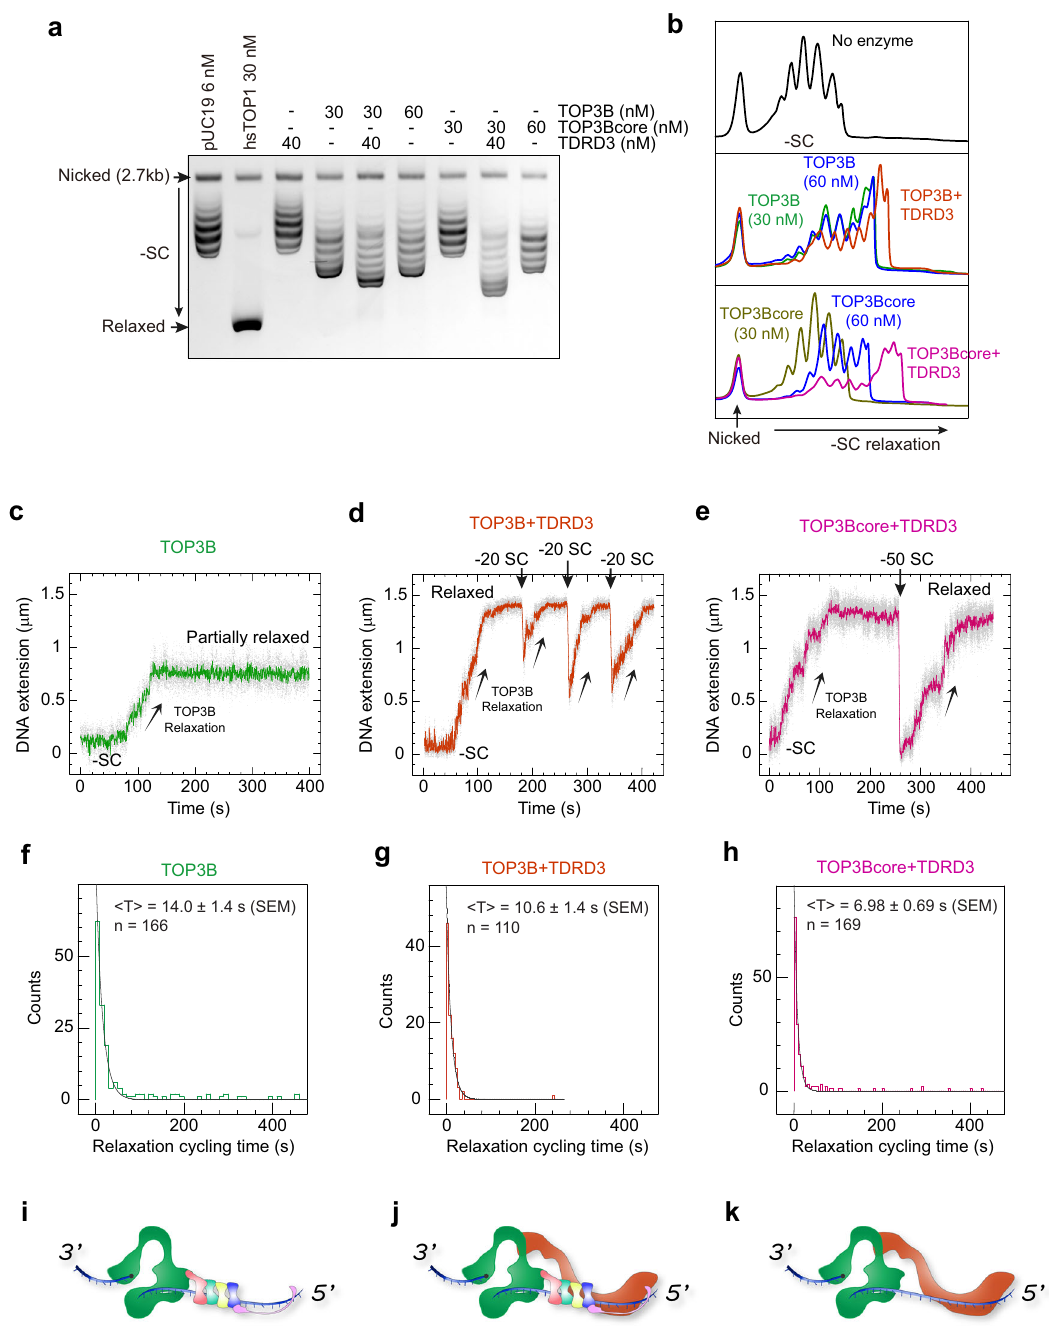
Fig. 6 | TDRD3 enhances both the processivity and catalytic rate of TOP3B. a Gel-based plasmid relaxation assay with TOP3B and TOP3Bcore in the presence and absence of TDRD3 (repeated twice independently with similar results). Ethi- diumbromide(0.15 μ g/ml)wasaddedtoboththeagarosegelandrunningbufferto convert the negatively supercoiled (-SC) DNA substrate and products into slightly overwound topoisomers. Fully relaxed plasmids by hsTOP1 were included (second lane) as a positive control. Numbers indicate the concentrations of DNA substrate and enzymes used. DNA relaxation assays were performed at 37°C for 1hr. b Quanti fi cationofDNAtopoisomerdistributions.Lanepro fi leswereobtainedwith ImageJ software. Peaks represent individual topoisomers. Overlapping product peaks allow direct observation of changes of DNA supercoiling levels catalyzed by the indicated enzyme combinations. c – e Representative single-molecule DNA